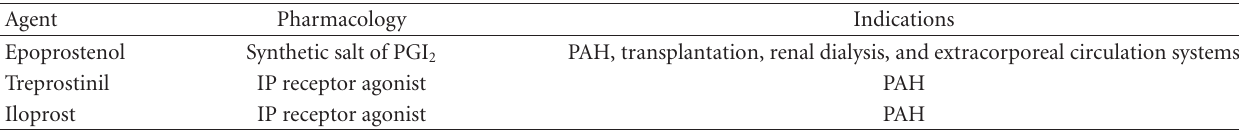
Table 1: Therapeutic use of PGI 2 —approved